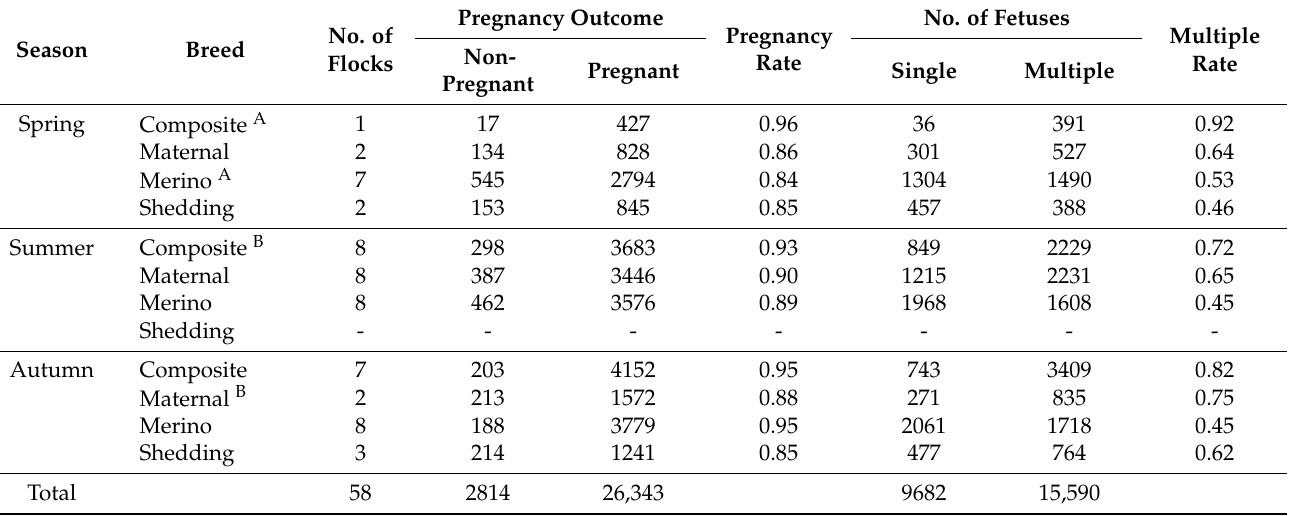
A One Composite and one Merino flock used Regulin ® ( Ceva Animal Health Pty Ltd., Glenorie, NSW, Australia), a melatonin hormone product. B Data for number of fetuses in one summer joined Composite flock and one autumn joined Maternal flock was removed from the dataset due to inaccurate scanning performance or because of a delayed date of scanning and accounts for the disparity between number of pregnant ewes and fetal number